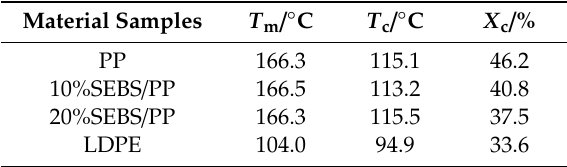
Table 1. Crystallization temperature T c , melting temperature T m and crystallinity X c of PP, LDPE and SEBS / PP composites.